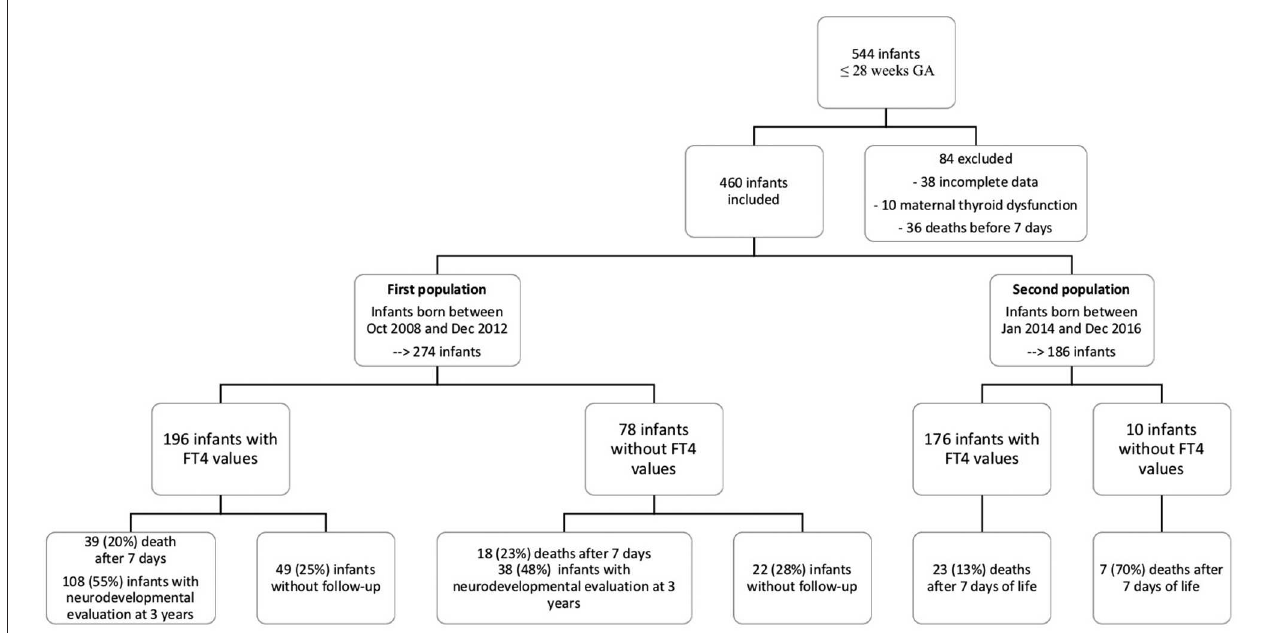
FIGURE 1 | Flow chart of the